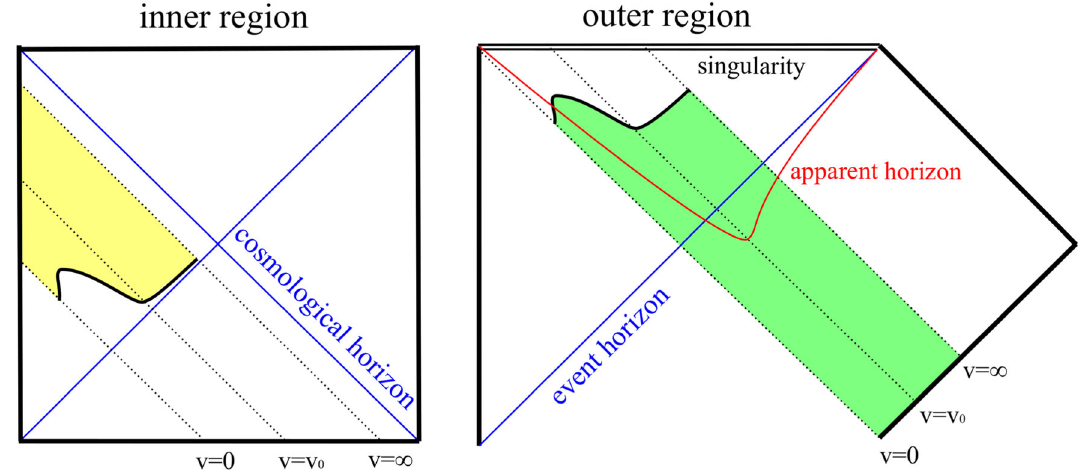
Fig. 4 Causal structure for the most natural initial conditions, where inside (left) is de Sitter space, outside (right) is Vaidya metric, and the thick black curve is the location of the shell. Only the yellow colored region for left and the green colored region for right are physical